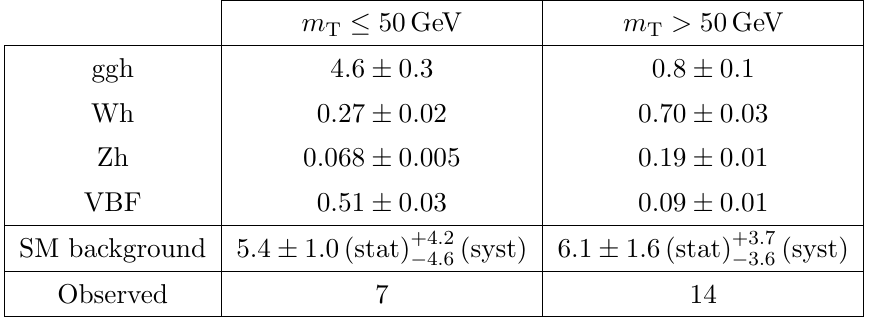
Table 3 . Expected signal yields for the h ! aa ! 4 (cid:28) process for a representative pseudoscalar mass of 9 GeV, in both m T bins, assuming SM cross sections and B (h ! aa) B 2 (a ! (cid:28) + (cid:28) (cid:0) ) = 0 : 1, in the context of the h ! aa ! 4 (cid:28) search. Expected background yields as well as observed numbers of events are also quoted. Only the statistical uncertainty is given for signal